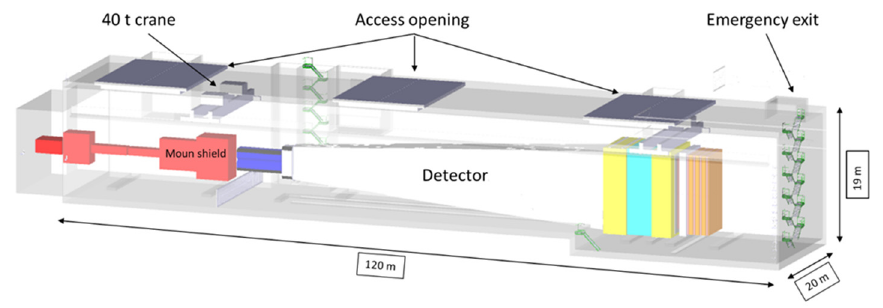
Figure 3. The experimental underground hall.